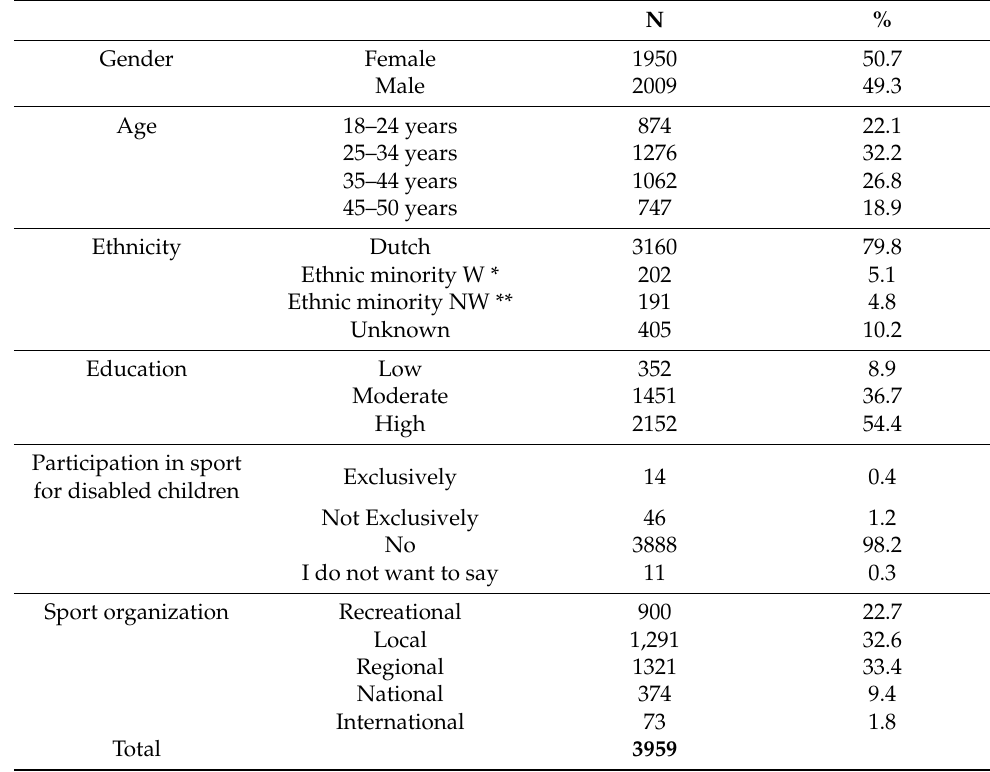
Table 2. Sociodemographic and sports participation characteristics for all respondents.